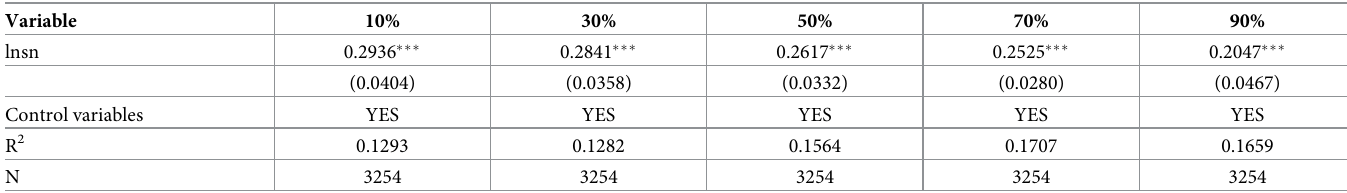
Table 10. Results of quantile